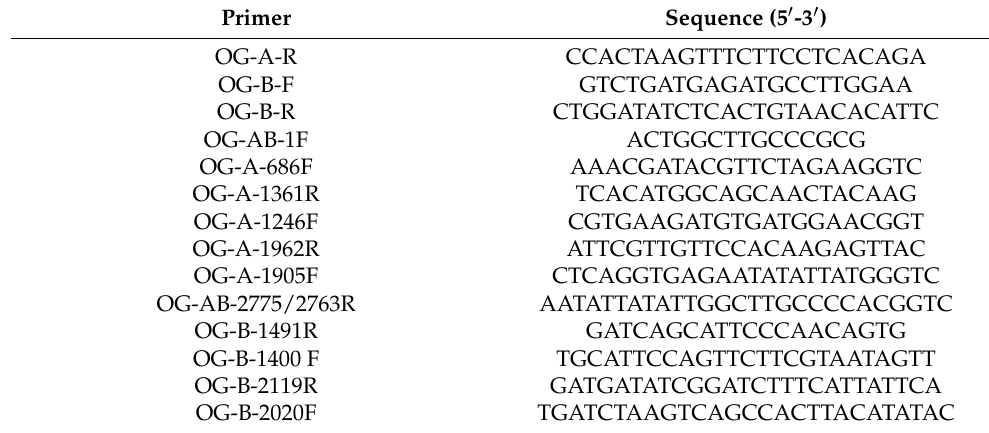
Table 2. Primers used for the complete amplification of OEGV genome by RT-PCR.